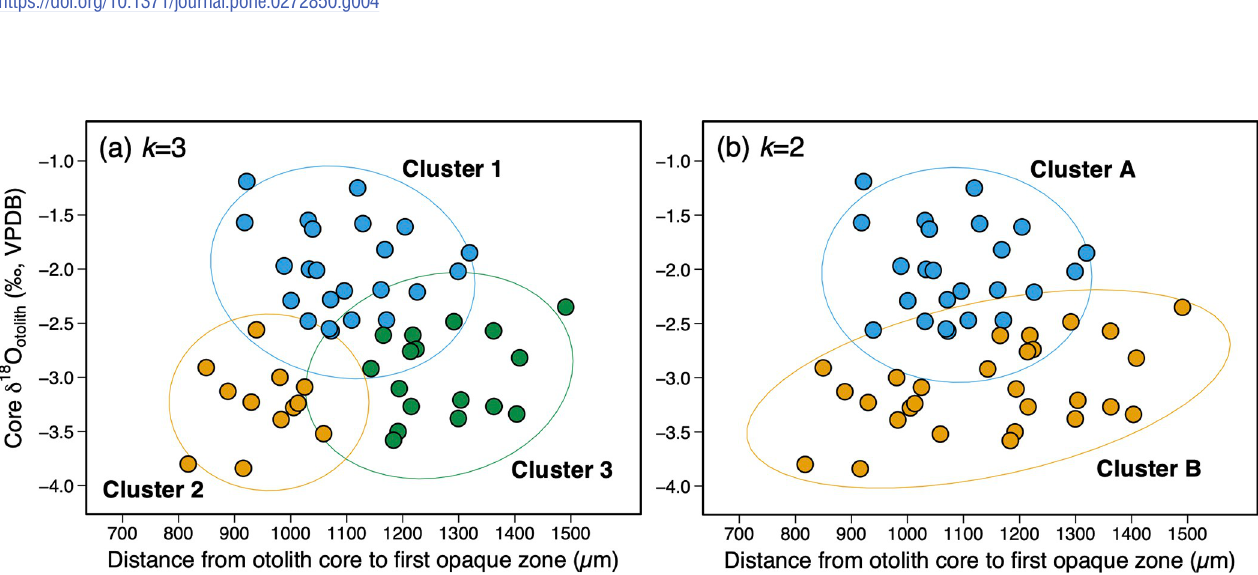
Fig 5. Clustering results on core δ 18 O otolith and the distance from otolith core to first opaque zone. The ellipses show 95% confidence intervals. (a) Clustering results when k = 3. Cluster 1 (blue circles) are fish presumed to be born in the Sea of Japan and Clusters 2 (orange circles) and 3 (green circles) are fish presumed to be born in the Nansei Islands area. (b) Clustering results when k = 2. Clusters A (blue circles) and B (orange circles) are fish presumed to be born in the Sea of Japan and the Nansei Islands area, respectively.